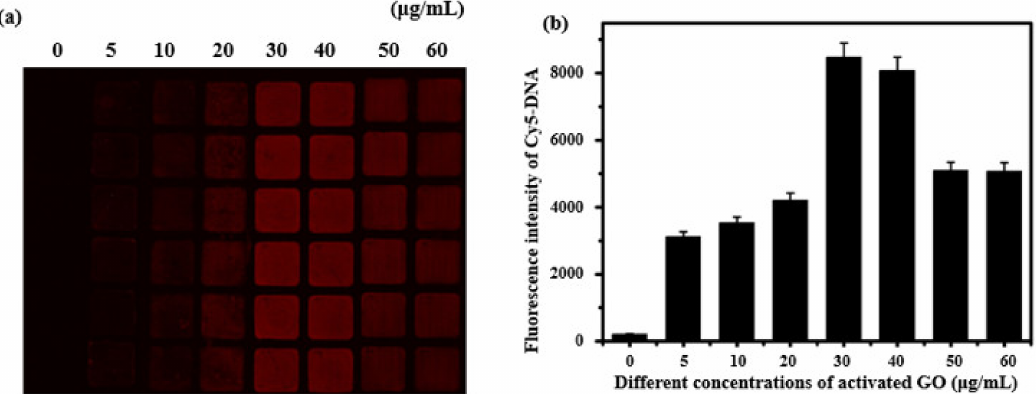
Figure 2. Optimization of activated GO concentration based on sensors containing DNA sequence I hybrid with one PS cutting site. ( a ) Scanning image of the chip microarray after optimization of activated GO concentration. ( b ) The fluorescence intensity of the Cy 5-DNA in the presence of different concentrations of activated GO.